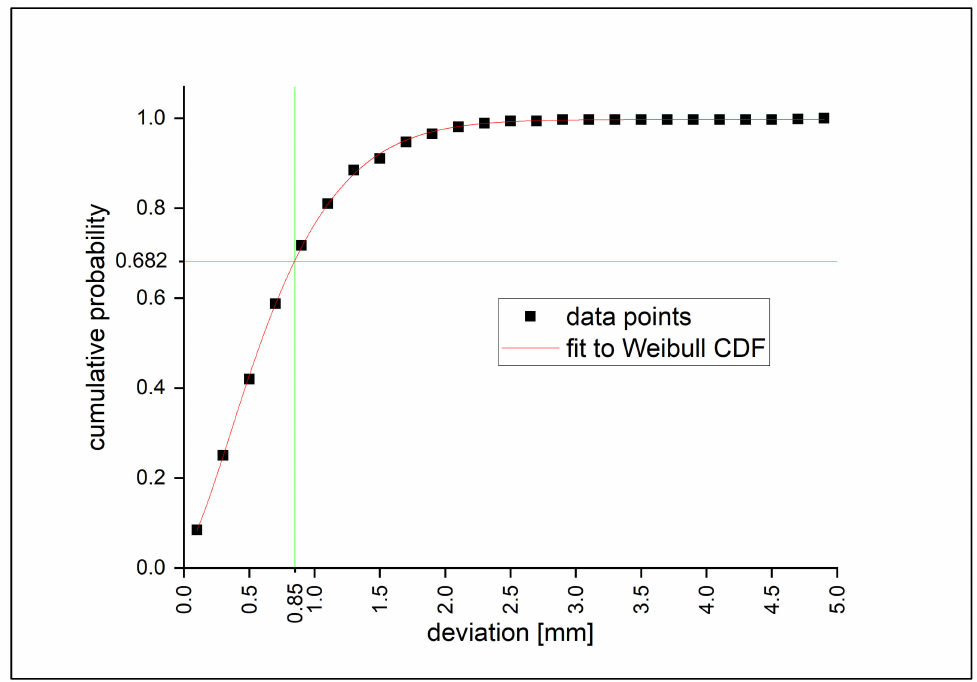
Figure 8. Cumulative probability plot of the spatial deviation (vector magnitude of x-, y- and z- deviation) of the feature points. The red line shows a Weibull cumulative distribution function (CDF) fit to these data points and is used to determine the standard deviation of the spatial deviation (shown in